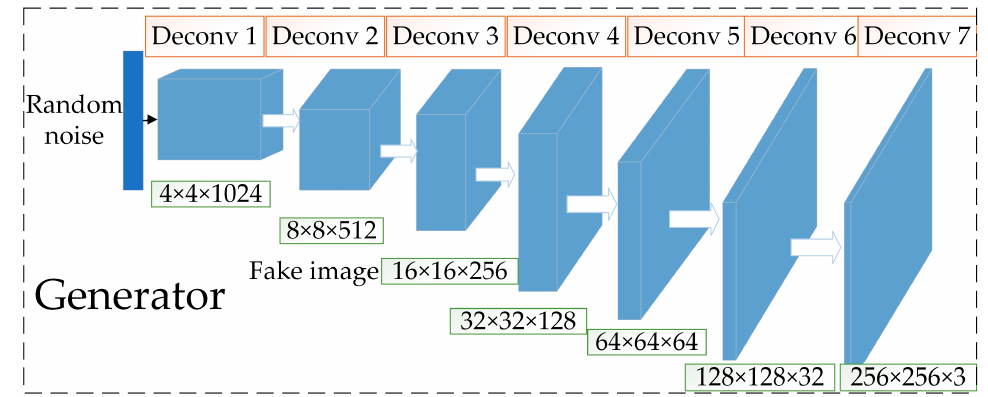
Figure 6. Improved generator.